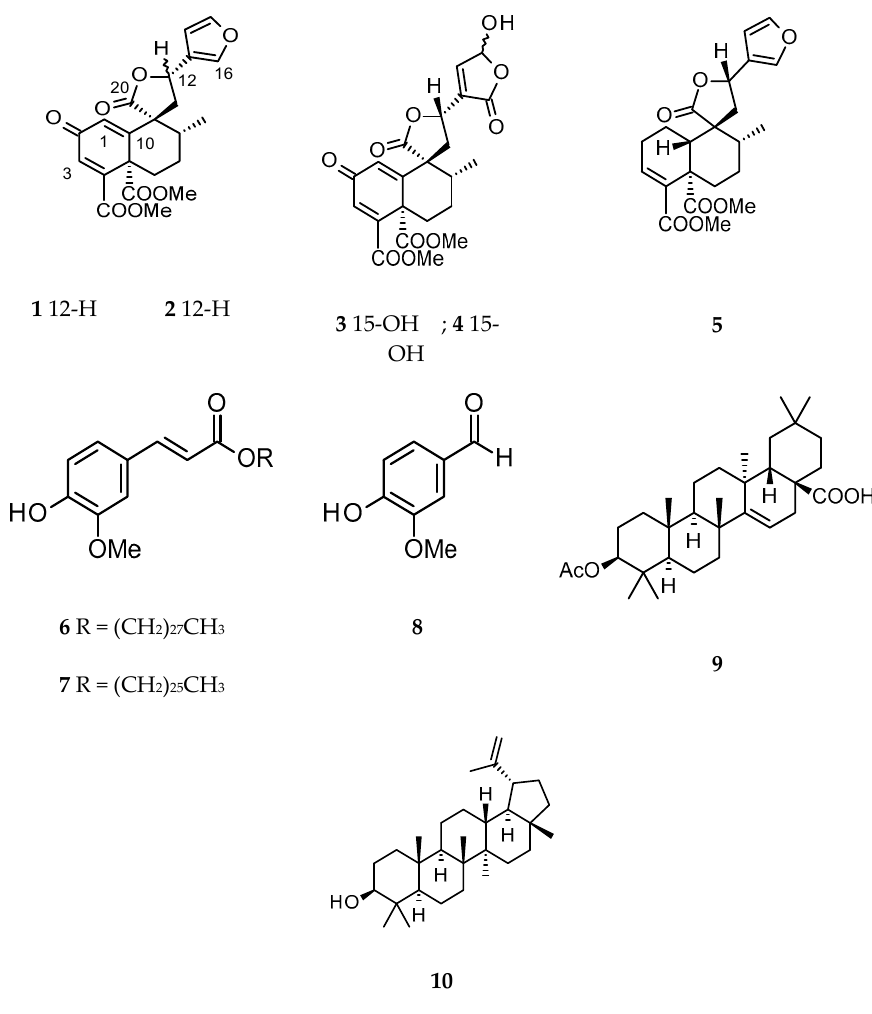
Figure 1. Chemical structures of compounds 1 – 10 .